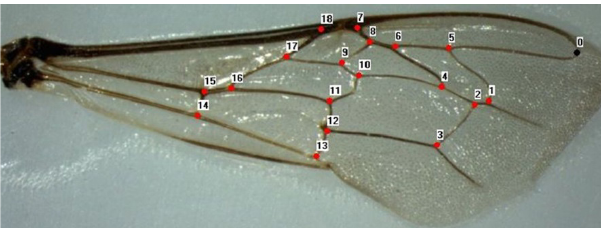
Fig 2. Right forewing of Anatolian honey bee with 19 landmarks plotted in the vein junctions.